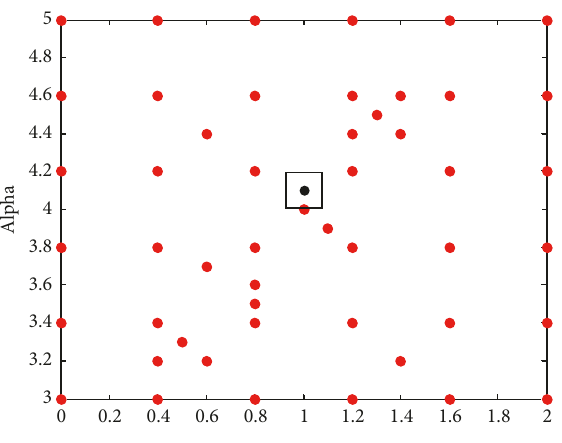
Figure 3: Final population (51 individuals) resulted from TMED algorithm. The black dot is the optimum location.